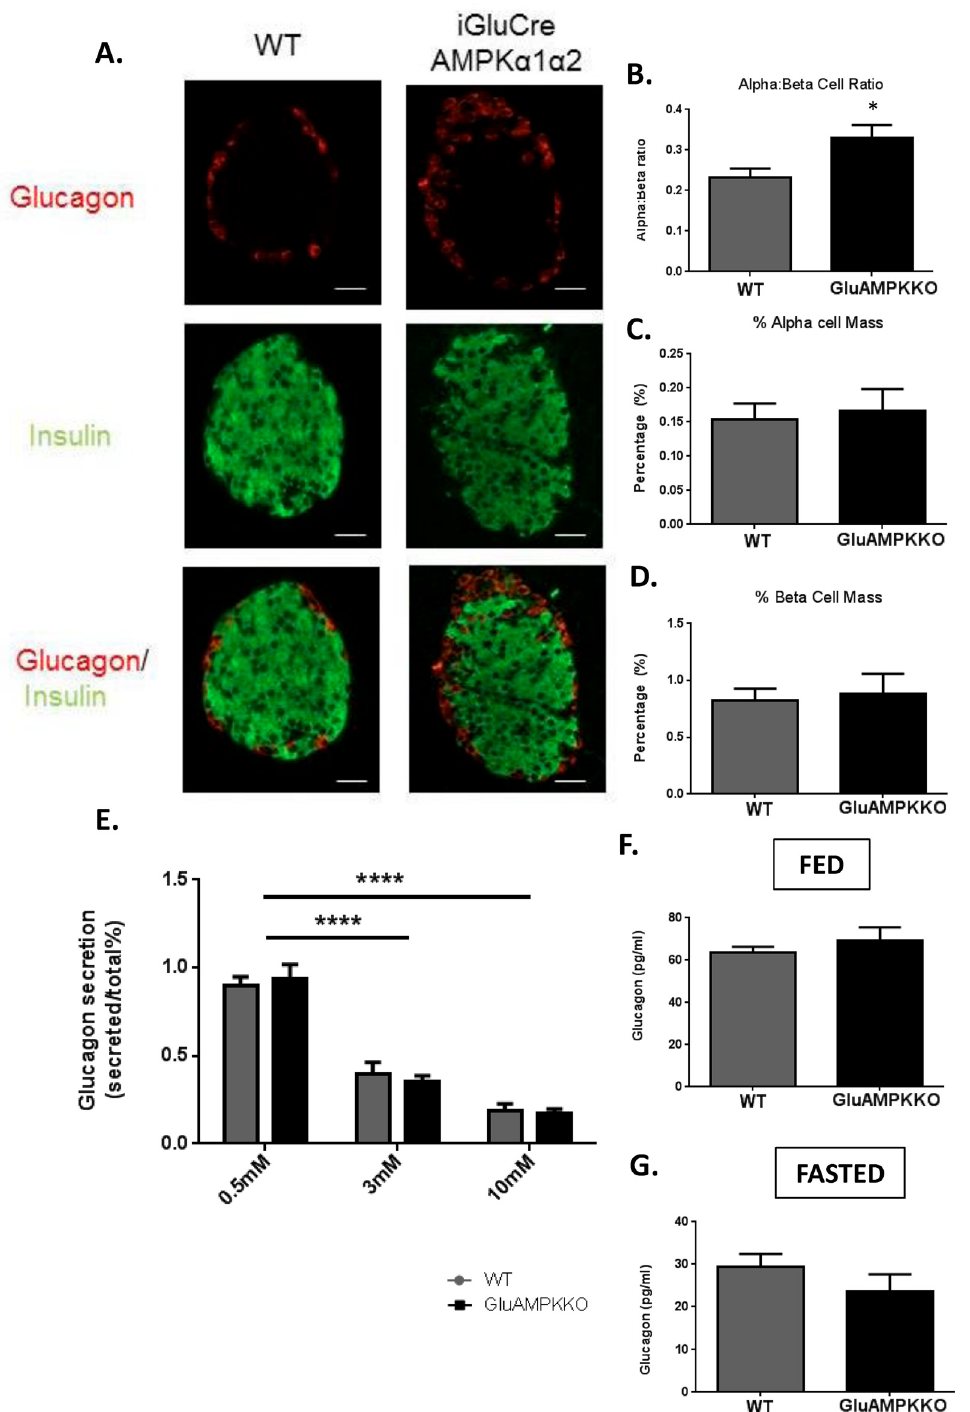
Fig 5. AMPK α 1, α 2KO has no effect on α -cell mass or glucagon secretion in male mice. (A) Immunofluorescent staining of pancreatic sections using guinea pig anti-insulin (1:200; green) or rabbit anti-glucagon (1:100; red) antibodies from iGluAMPKdKO or WT mice. (B) Alpha:beta cell ratio, (C) % alpha- cell mass, (D) % beta-cell mass; n = 3 mice/genotype (all male), (E) glucagon secretion, measured from 12 size-matched islets incubated in 0.5, 3 or 10 mmol/l glucose and measured using radioimmunoassay, (F,G) levels of glucagon in the plasma of iGluAMPKdKO and WT mice when fed or fasted overnight. n = 6 mice/genotype, * P < 0.05, by Student ’ s t-test; **** P < 0.0001 by 2-way ANOVA. Data are expressed as means ± SEM.